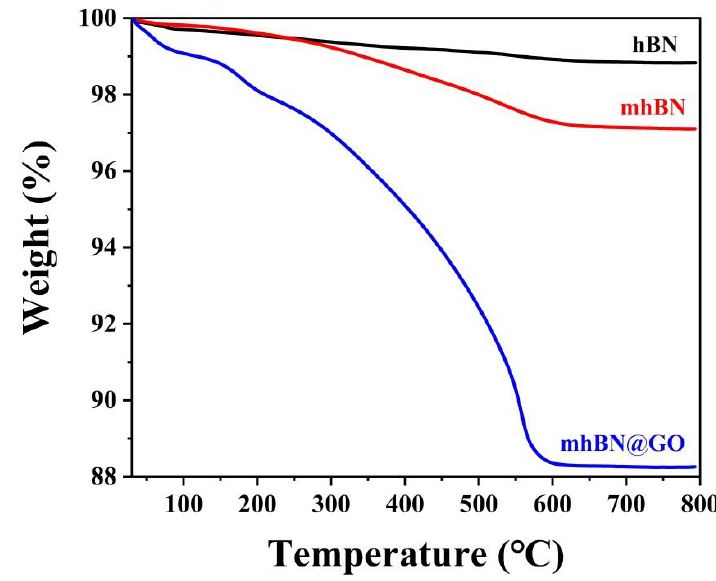
Figure 2. TGA curves of hBN, mhBN, and